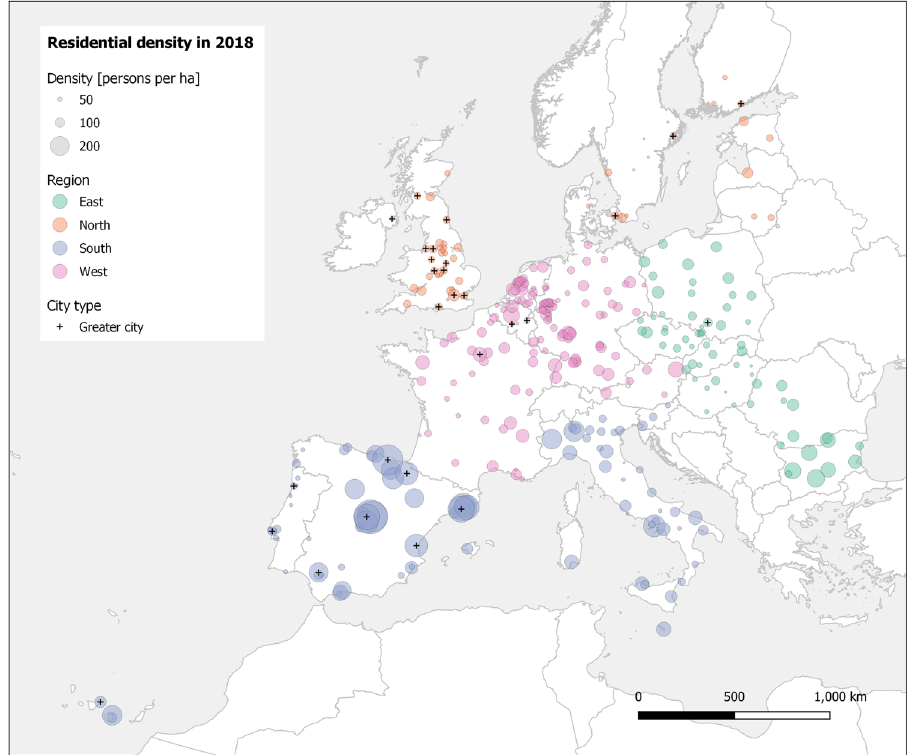
Fig. 1 Residential density of European cities in 2018. The 331 analyzed cities are classi fi ed according to the region. A mark indicates greater cities, i.e. urban agglomerations extending beyond the administrative boundaries of the respective core